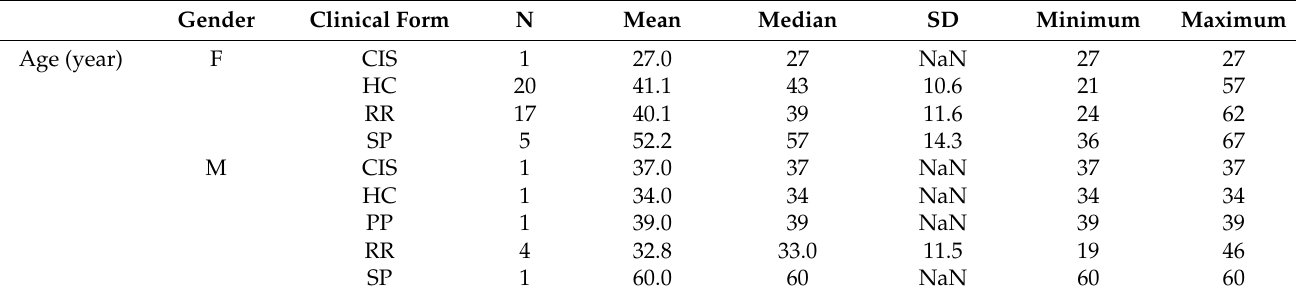
Table 1. Clinical-demographic